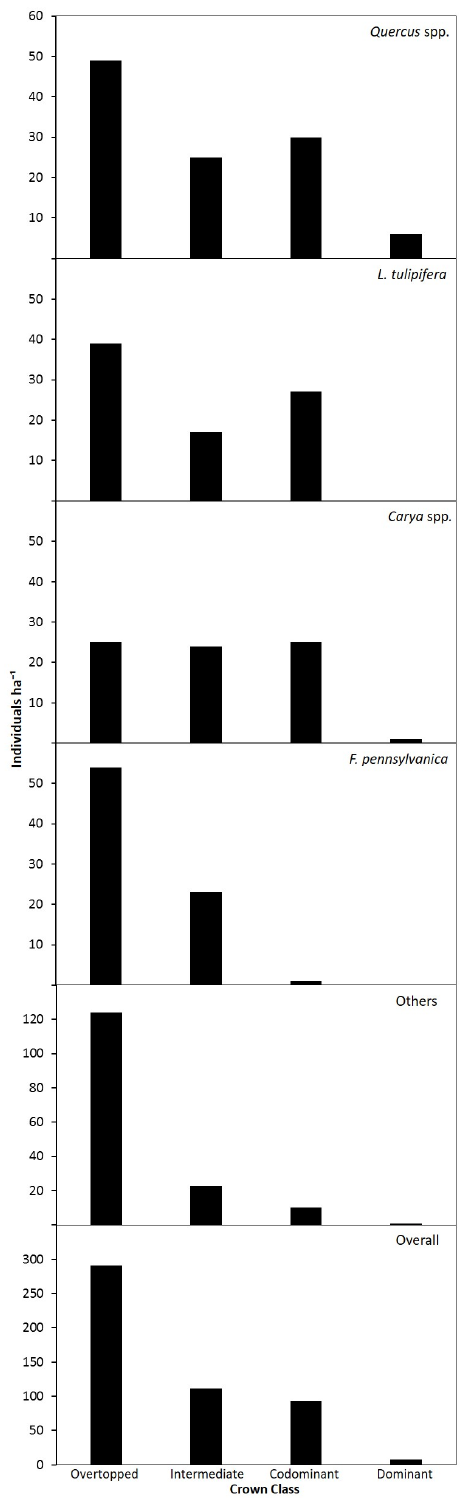
Figure 2. Crown class distributions of trees ( ≥ 5 cm dbh) by group in a multi-cohort forest on the Oakmulgee Ranger District of the Talladega National Forest, Alabama. Crown classes are based on the amount and direction of intercepted light [22]. See Table 1 for a list of species included in the others group.